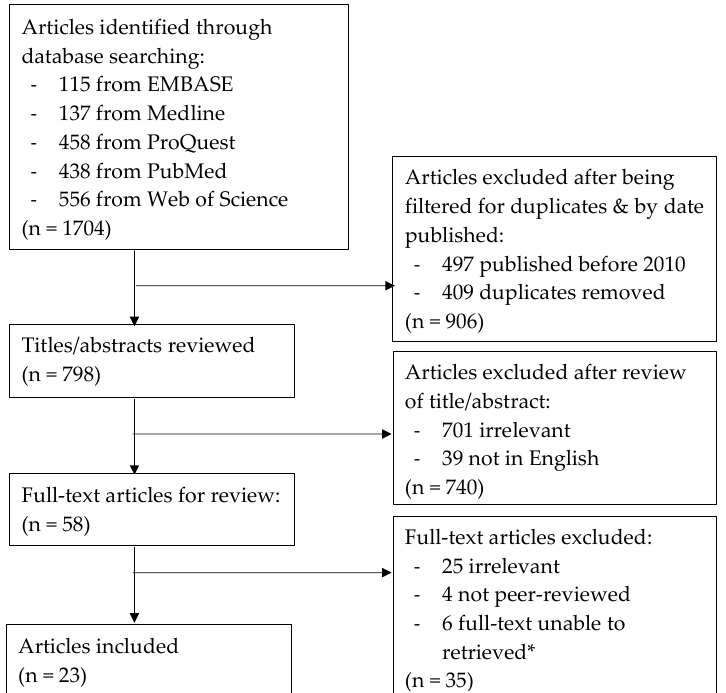
Figure 1. PRISMA research method. Summary of articles identified, screened and included in literature review, adapted from Moher et al. [11]. * Articles where the full text could not be retrieved were published as supplement articles (abstracts presented at a